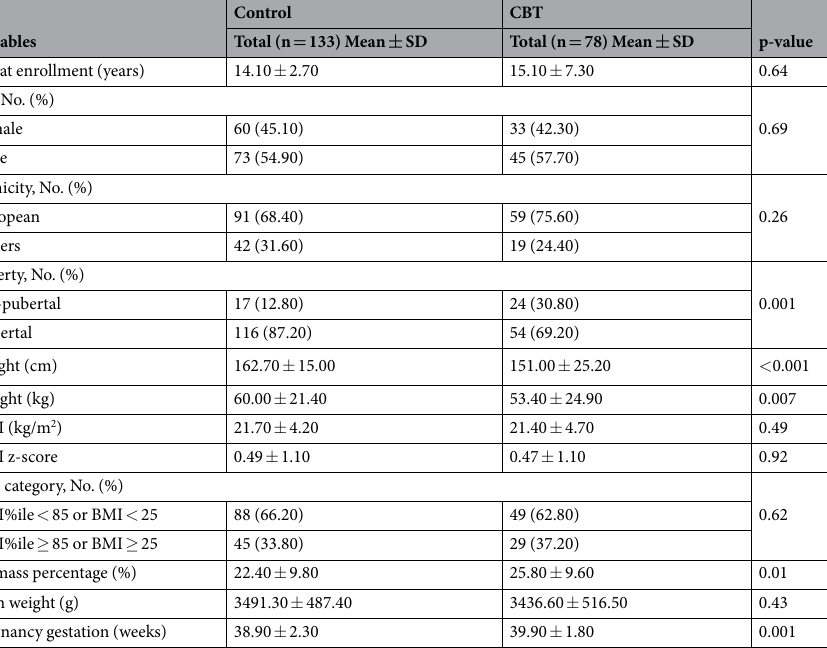
Table 1. Characteristics of study population. Abbreviations: CBT, Children with Brain Tumors; SD, Standard Deviation; BMI, Body Mass